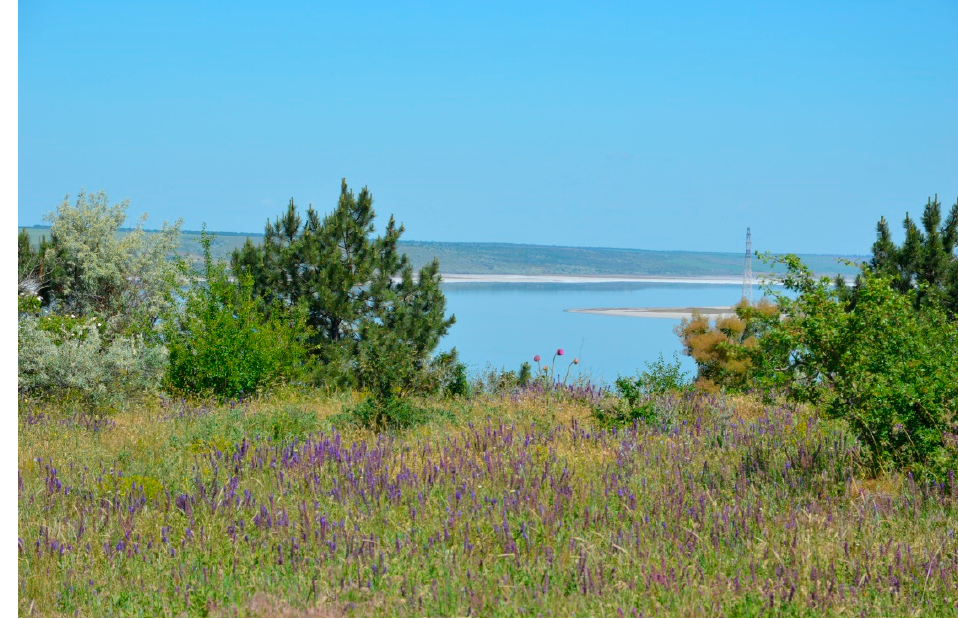
Figure 21. A fragment of the communities of Salvio nemorosae-Festucetum valesiacae association on artificial terraces (surroundings of Ilinka village).